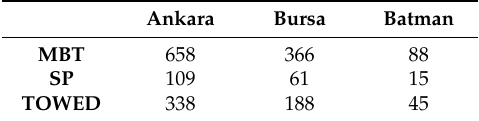
Table 4. Capacities of cities of weapon types MBT, SP, and